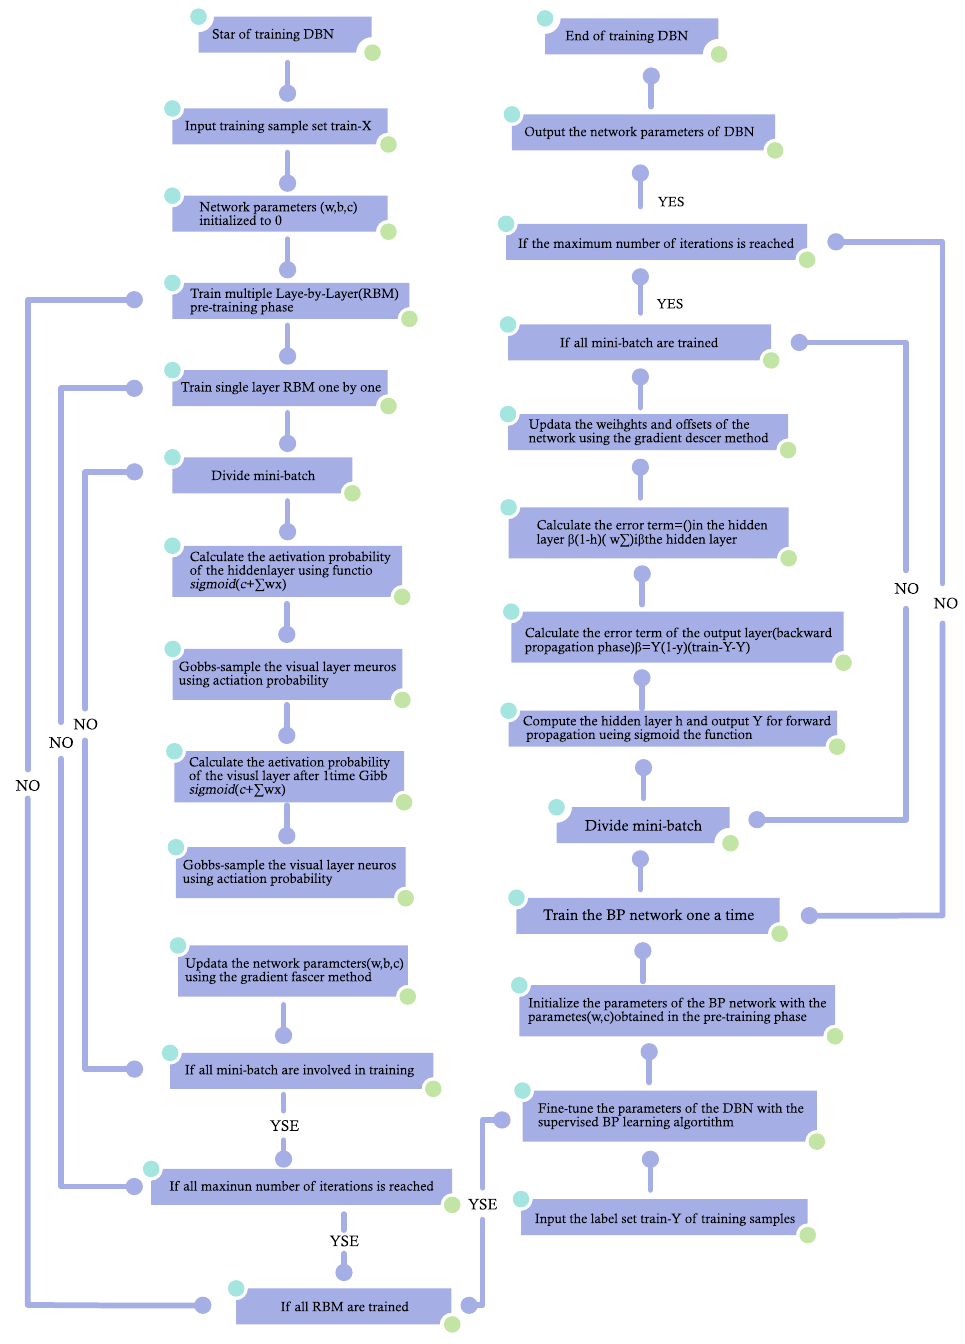
Figure 5. The DBN training